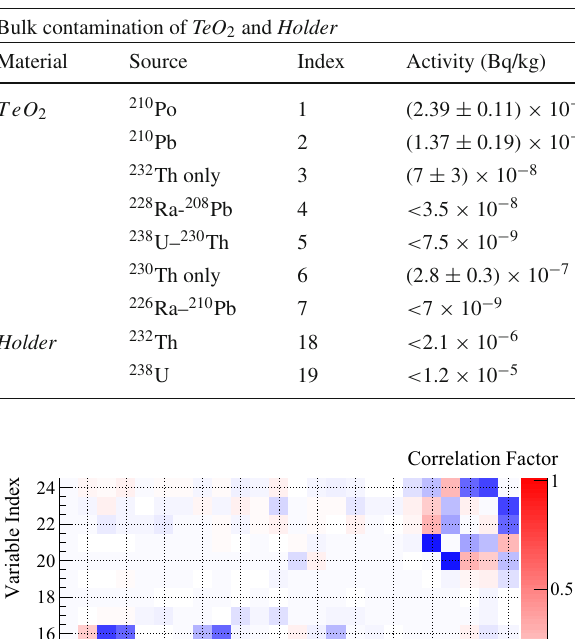
Table 5 Values and 90% C.L. upper limits on bulk contaminations in the TeO 2 crystals and the Holder based on the background model of CUORE-0 [42]. Contaminants are identified as follows: when the progenitor is indicated all the chain is assumed in secular equilibrium, in all other cases single isotopes or sub-chains of 232 Th and 238 U are considered. Each contaminant is assigned a unique index for future reference